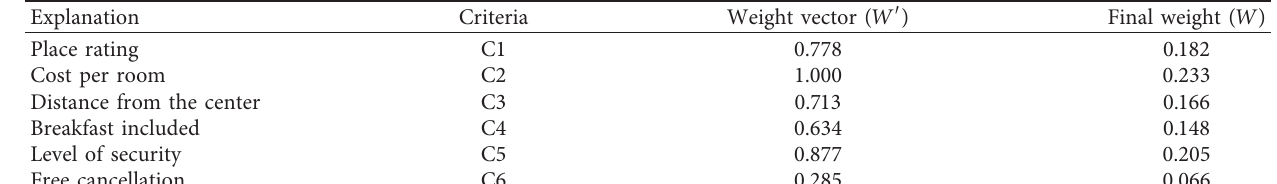
Table 6: Weight vectors and the normalized final weights of